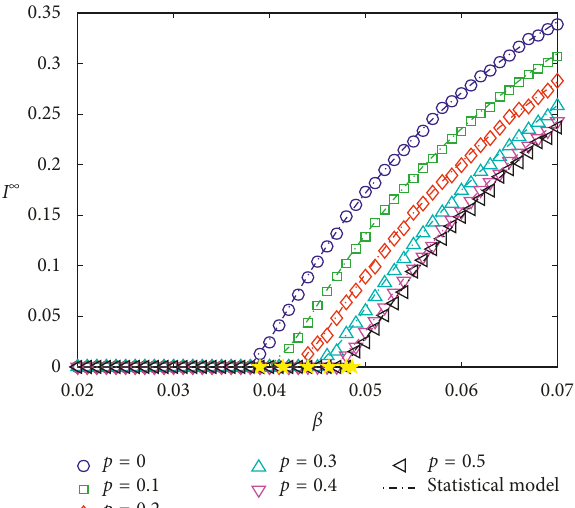
Figure 5: The final fraction of infectious nodes as a function of the infection rate β for different proportions of type A nodes, p . The epidemic thresholds suggested by the Monte Carlo simulation and the statistical model are recorded as soon as I ∞ is slightly than 0.01 (the critical value above which the realization is considered as endemic). The analytical values of the epidemic threshold given by equation (27) are labeled by yellow pentagons.